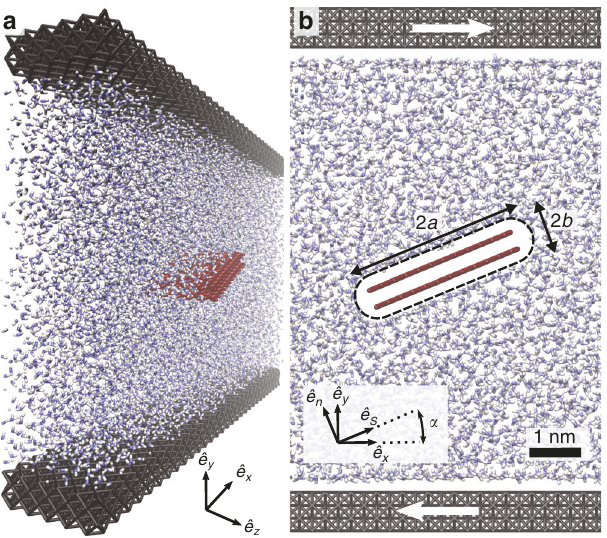
Fig. 1 View of the MD system. a Perspective view of a graphene bilayer in a shear fl ow of strength _ γ , as extracted from MD simulations 80 . The blue and white dots are water molecules, and the black layers at the top and bottom are the shearing walls. b Zoom on the graphene bilayer, inclined by an angle α with respect to the fl ow. Comparison with continuum simulations is made by calculating the stress on the continuous surface represented by the dashed outline.